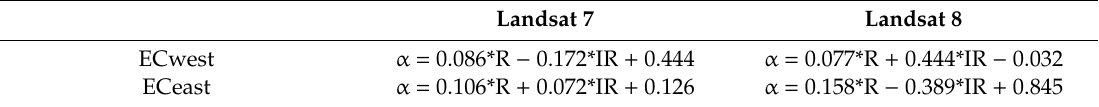
Table 1. Best reflectance combinations to retrieve albedo from Landsat data. R is for red and IR is for